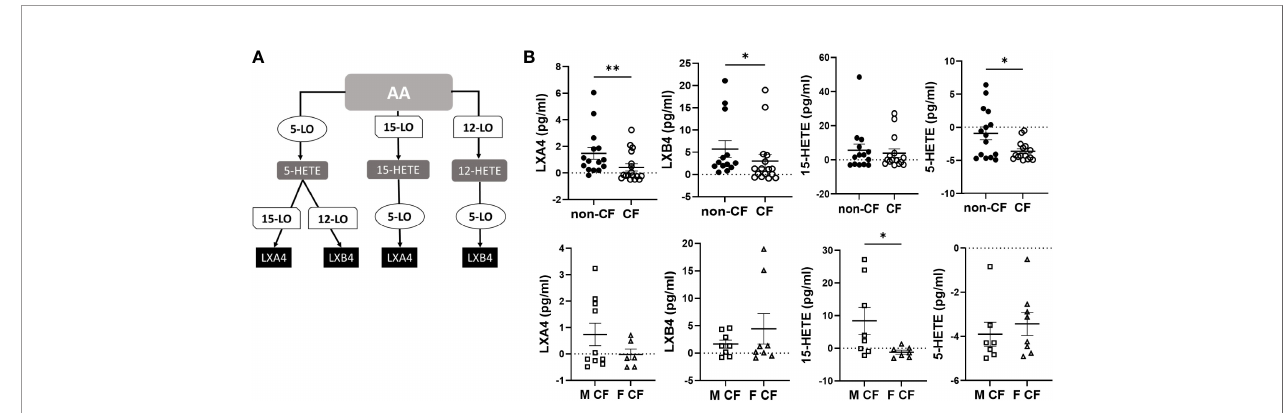
FIGURE 2 | Arachidonic acid (AA) derived SPMs biosynthesis. (A) Schematic illustration of the lipoxin A4 (LXA4) and lipoxin B4 (LXB4) biosynthesis ’ pathway showing the enzymes involved, 5-lipoxygenase (LO), 15-LO and 12-LO as well as their intermediates substrates, 5- hydroxyeicosapentaenoic acid (HETE), 15-HETE and 12-HETE. (B) Comparison of the mean levels of each AA metabolite (LXA4, LXB4, 5-HETE and 15-HETE) between samples derived from non-CF and CF subjects (top) and from male and female CF patients (bottom). (Mann-Whitney test. *p<0.05),